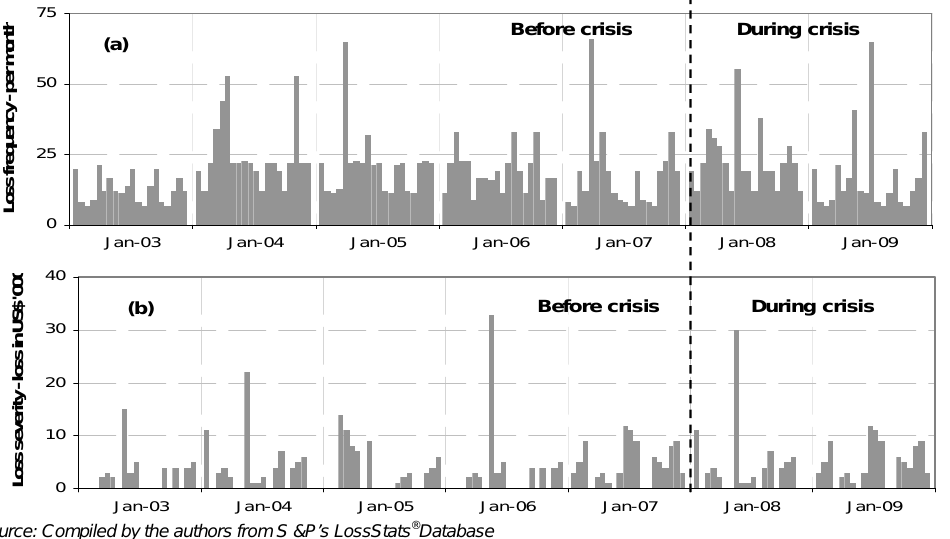
Monthly credit loss (a) frequency and (b) severity for the periods under investigation for banks using the